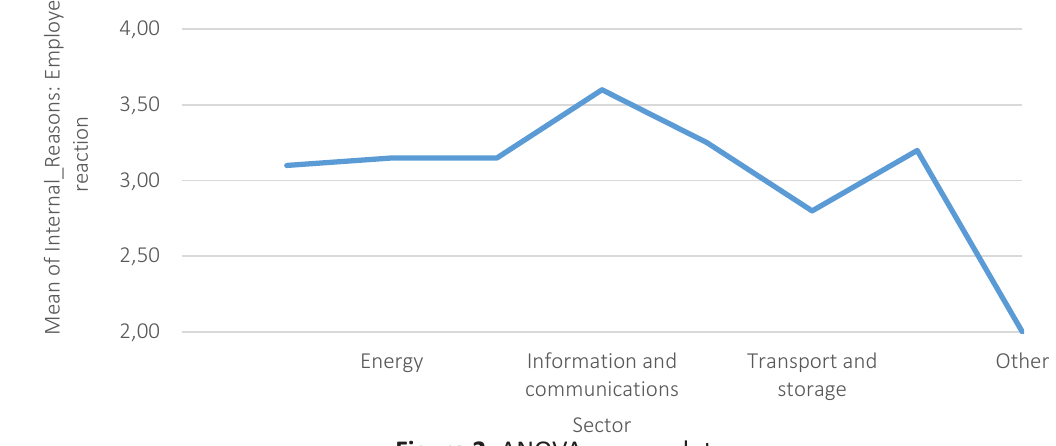
Figure 2. ANOVA means